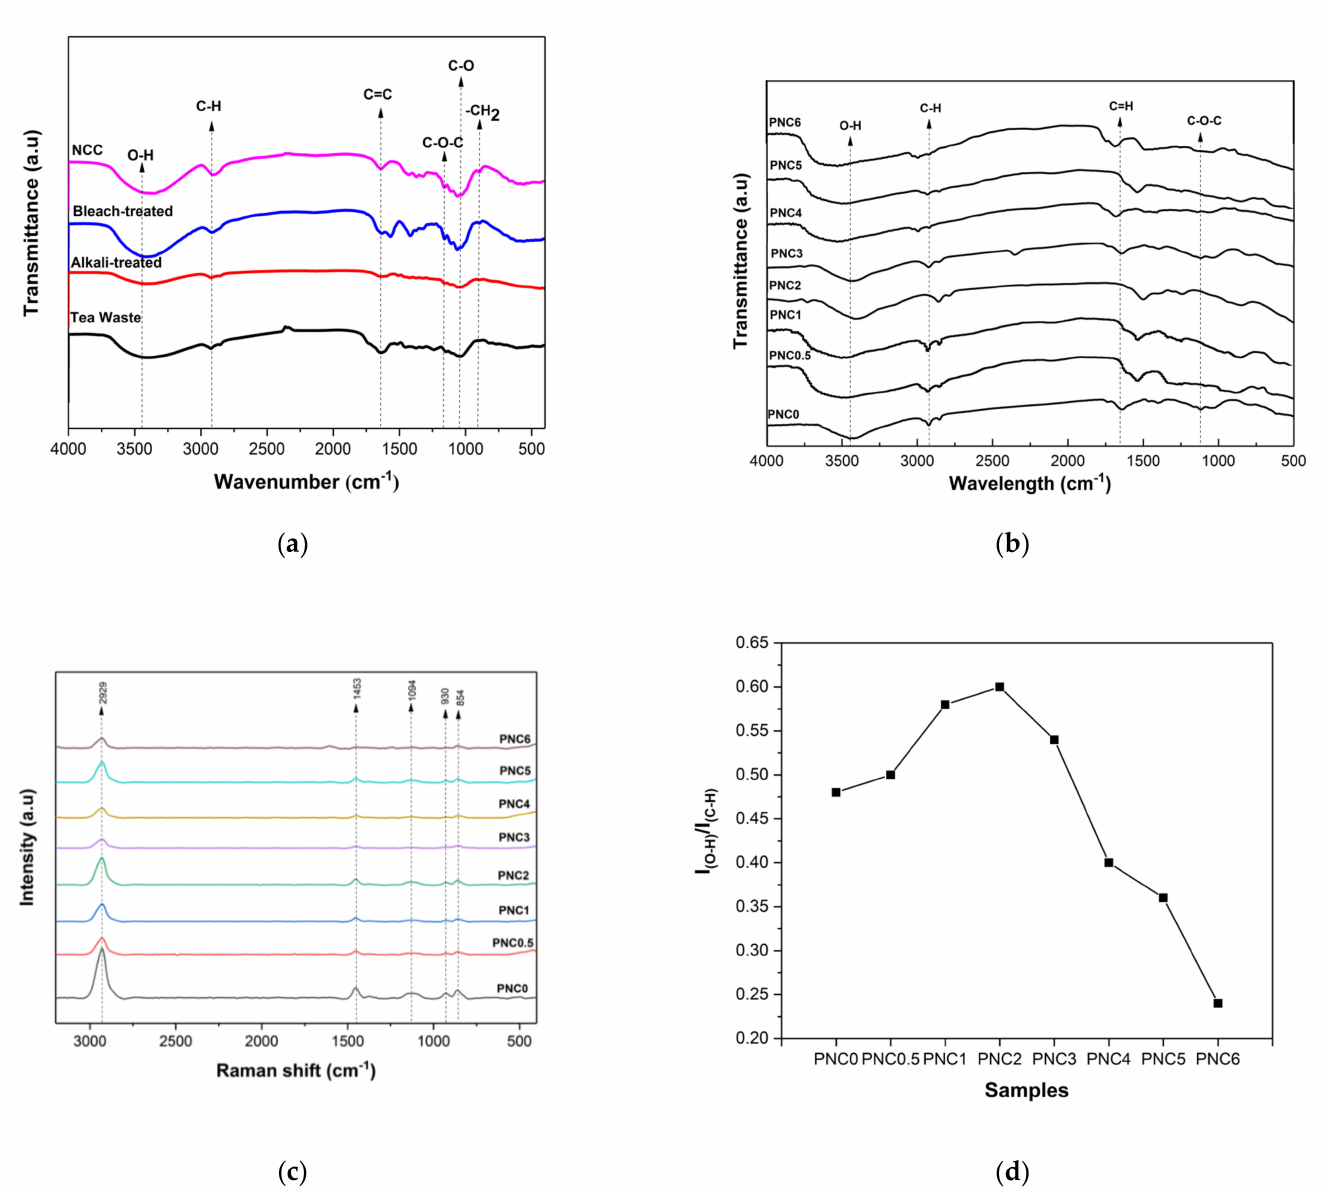
Figure 1. ( a ) FTIR spectra of any chemical treatment of tea waste. ( b ) FTIR spectra of PVA–NCC nanocomposite films. ( c ) Raman spectra of PVA–NCC nanocomposite films. ( d ) Intensity ratios of I ( O − H ) / I ( C − H ) PVA–NCC nanocomposite